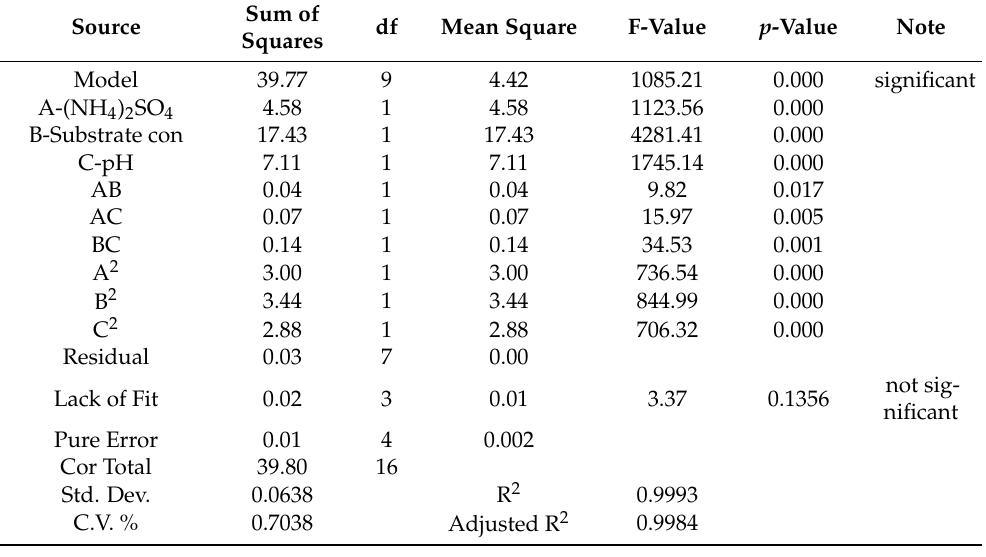
Table 4. Analysis of variance of the Box–Behnken model for ethanol production by M. guilliermondii H1.